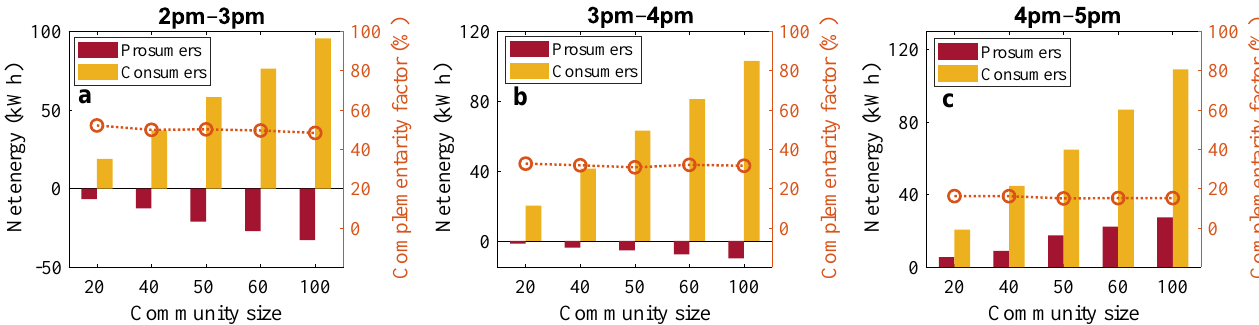
Figure 7. Comparison of surplus energy, deficit energy, and complementarity factor (CF) for various community sizes with an equal number of prosumers and consumers at ( a ) 2–3 p.m., ( b ) 3–4 p.m., and ( c ) 4–5 p.m. The left axis represents the net energy values, and the right axis represents CF